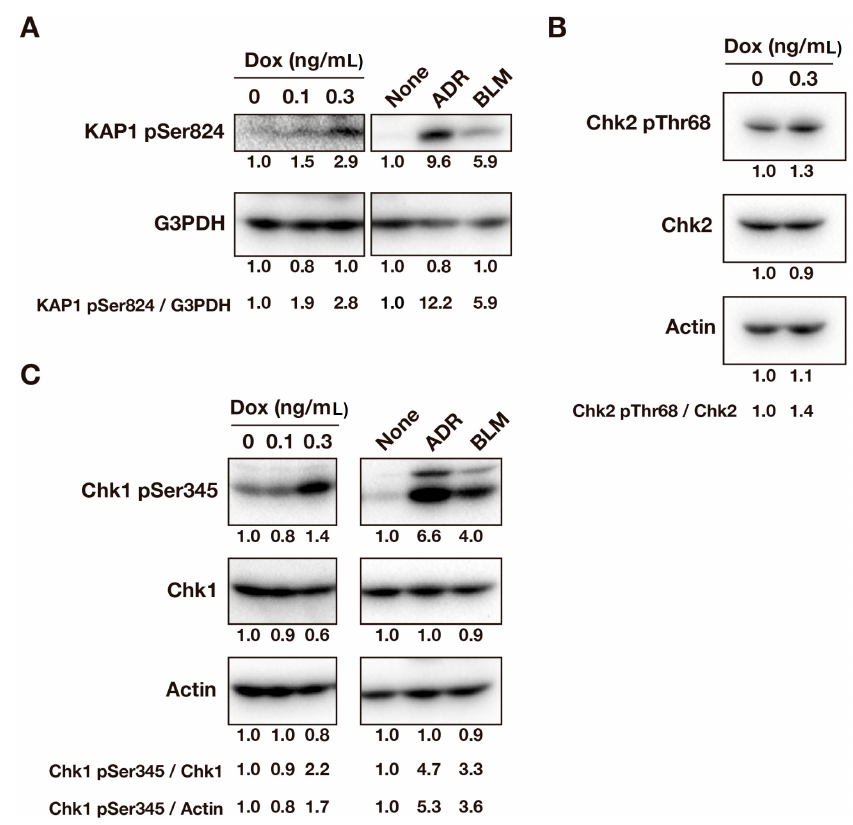
Figure 3. v-Src induces ATM/ATR activation. HCT116/v-Src cells were cultured with Dox at the indicated concentrations for three days. ADR (300 ng/mL) and BLM (4.46 μ g/mL) were used as the positive control and cells were treated for one day before lysate preparation. Whole cell lysates were subjected to a Western blot analysis. A representative result of two independent experiments is shown. ( A ) Blots were probed with anti-KAP1 pSer824 and anti-G3PDH (loading control) antibodies. KAP1 phosphorylation at Ser824 was quantified by measuring the signal intensities of the bands. The ratios to the levels of G3PDH are shown; ( B ) Blots were probed with anti-Chk2 pThr68, anti-Chk2, and anti-actin (loading control) antibodies. Chk2 phosphorylation at Thr68 was quantified by measuring the signal intensities of the bands. The ratios to the Chk2 are shown; ( C ) Blots were probed with anti-Chk1 pSer345, anti-Chk1, and anti-actin (loading control) antibodies. Chk1 phosphorylation at Ser345 was quantified by measuring the signal intensities of the bands. The ratios to the Chk1 and actin levels are shown.